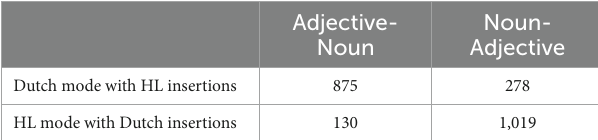
TABLE 3 Produced word order in the code-switching experimental modes.